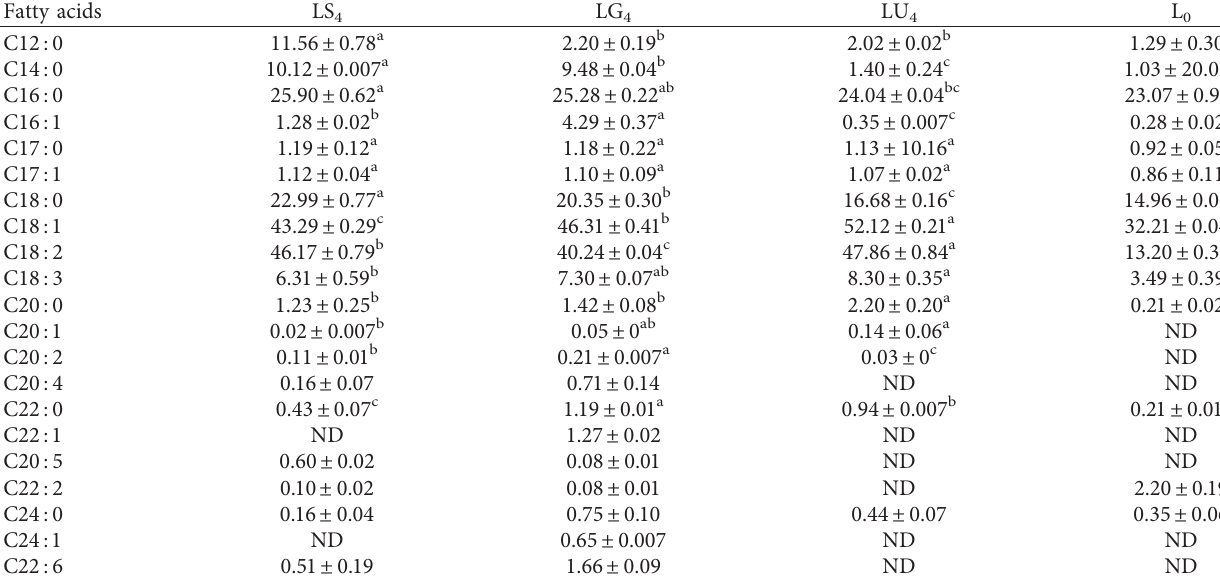
Table 4: Fatty acid profile of fruit paste samples with 3% algae powder.